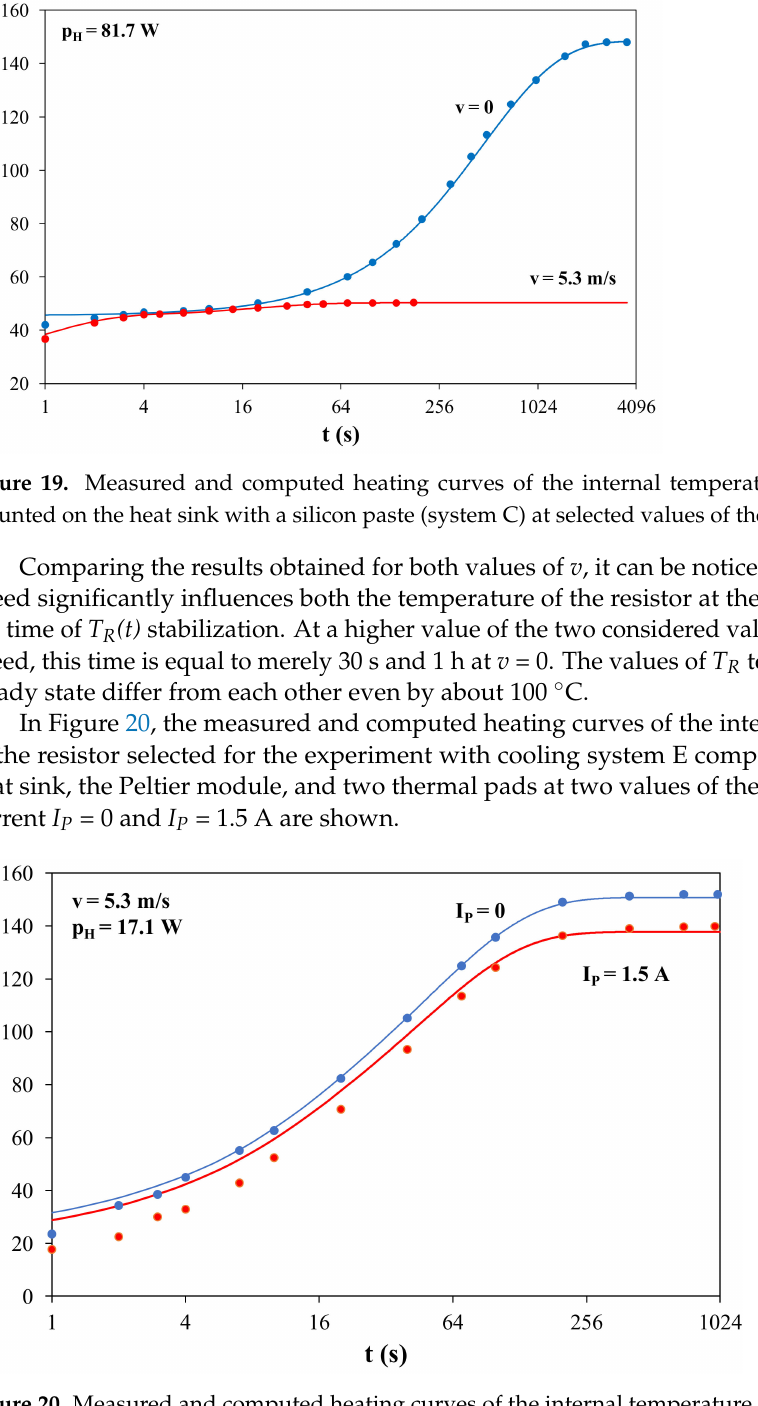
Figure 20. Measured and computed heating curves of the internal temperature of the resistor with cooling system E at two values of the Peltier module’s current (system